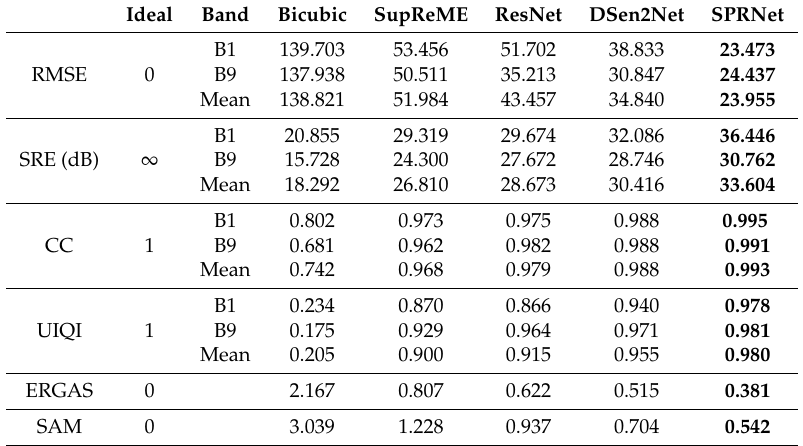
Table 4. Quantitative assessment of the SPRNet 6 Bold indicates the best performance.